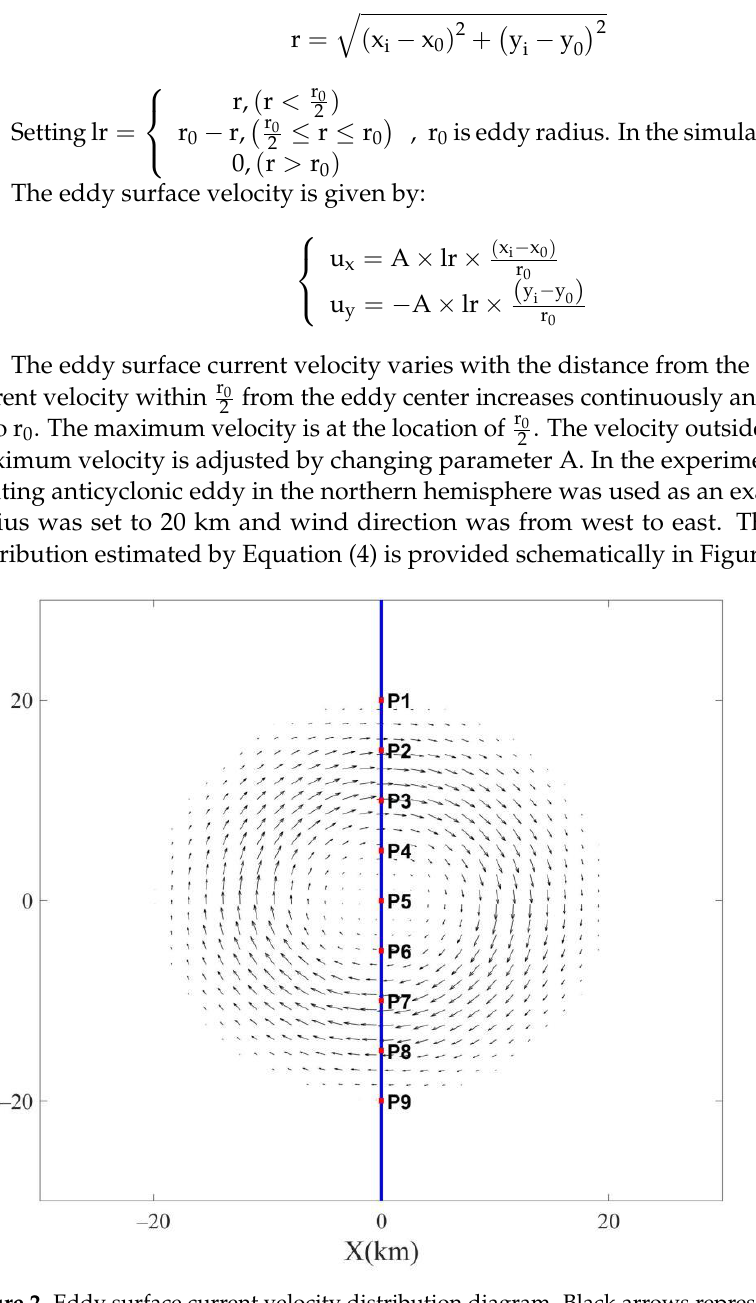
Figure 2. Eddy surface current velocity distribution diagram. Black arrows represent current vectors. The blue line and red dots are the section used to analyze the wave parameter variations in Section 3.3.